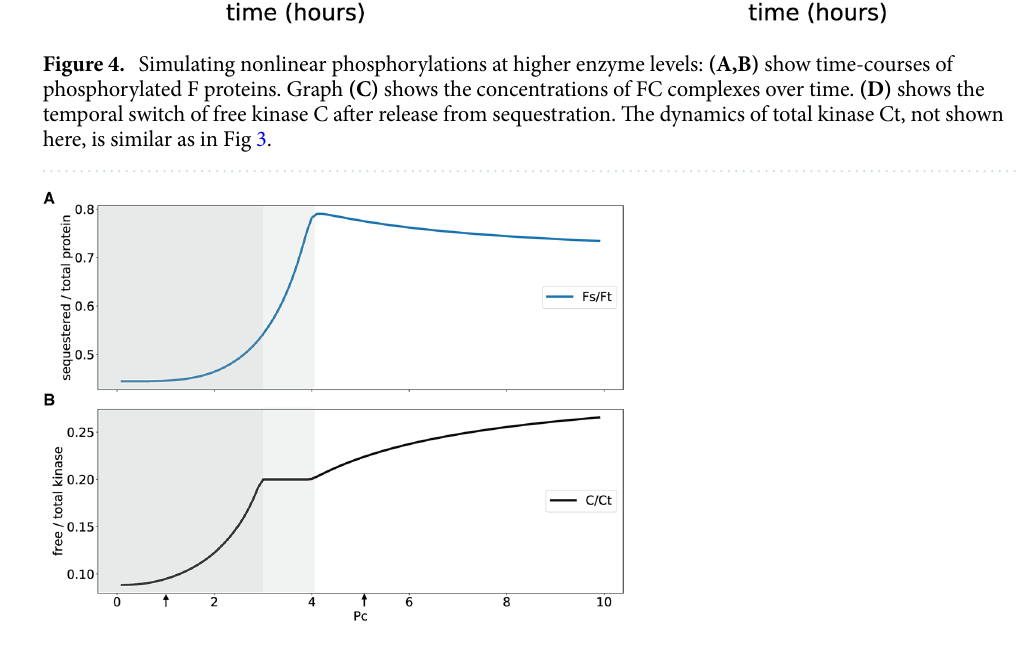
Figure 5. Simulating sequestration based transitions: (A) shows the ratio of sequestered to total F for varying kinase production. (B) shows the ratio of free to total kinase for increasing kinase